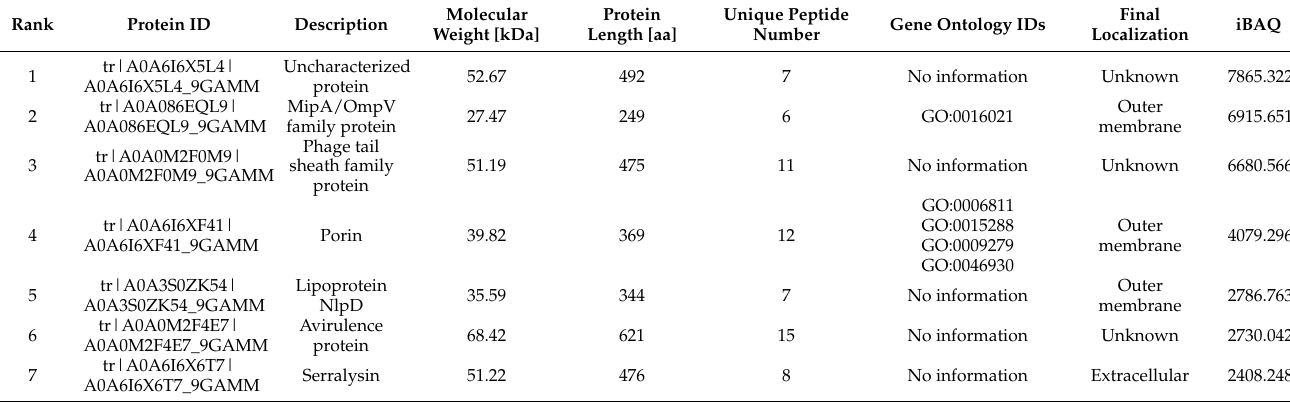
Table 2. The top 50 most abundant OMV proteins of Pbr1692 based on